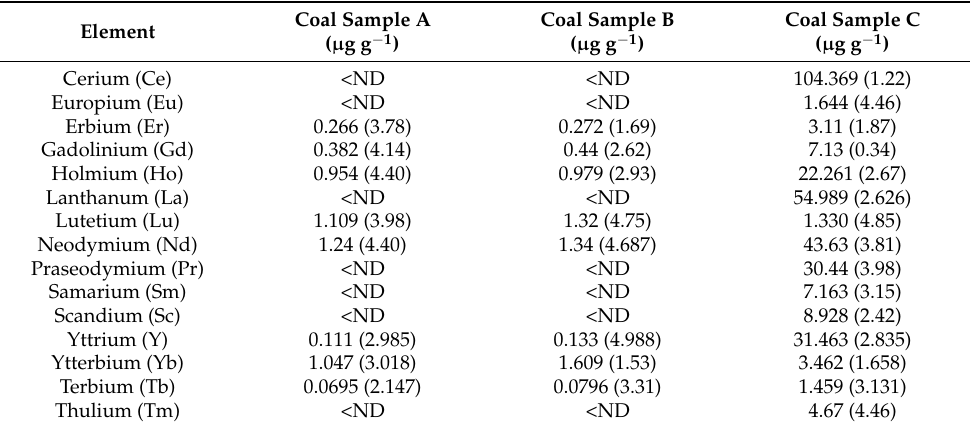
Table 6. Concentration levels of REEs in three South African coal samples obtained by using MAA- UAE followed by ICP-OES), n =